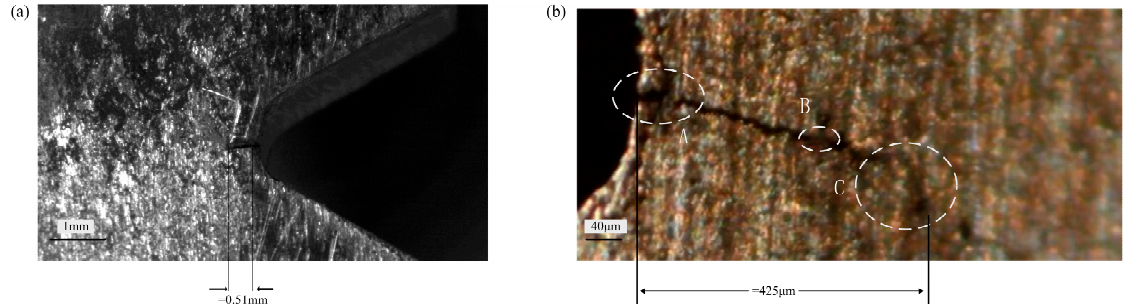
Figure 4. Crack initiation at root of notched specimen. ( a ) Ordinary macro-crack; ( b ) non-propagating crack; Crack closure occurred in areas A, B and C.